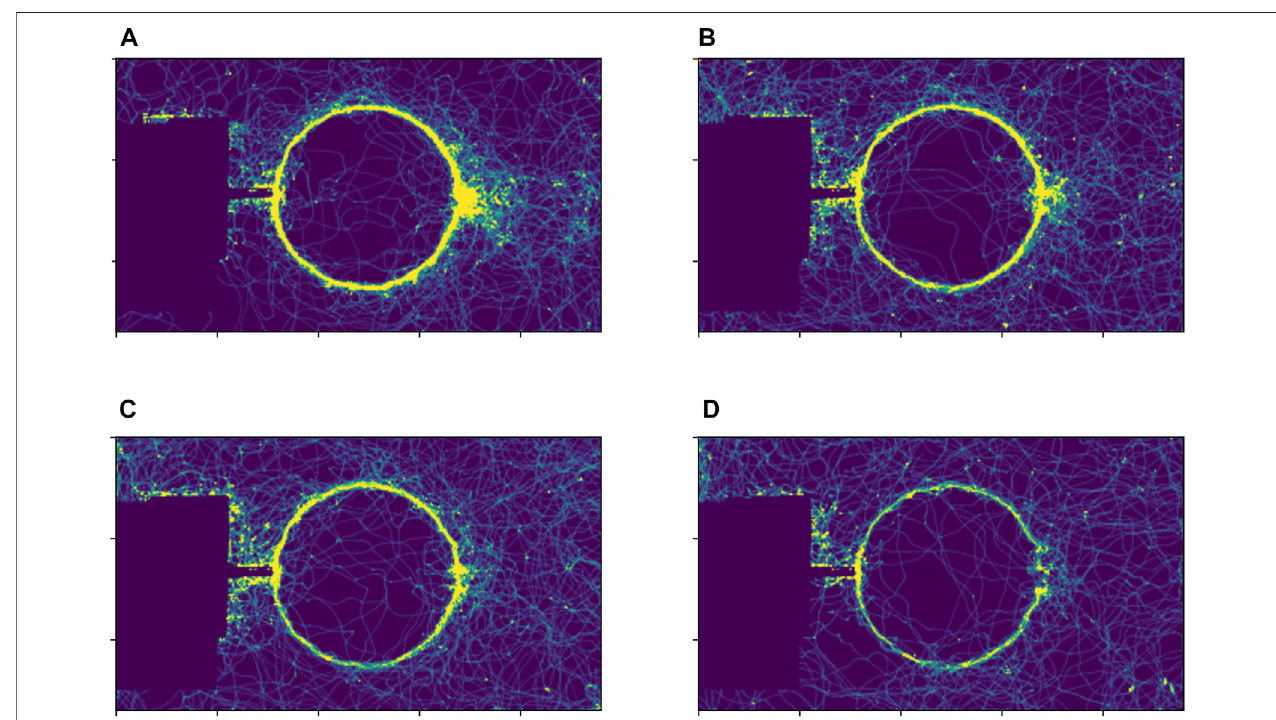
FIGURE 3 | Example of the density of foraging ants in the experiment without a food source: (A) an interval from 0 to 3 min, (B) an interval from 3 to 6 min, (C) an interval from 6 to 9 min, (D) an interval from 9 min to 12 min.